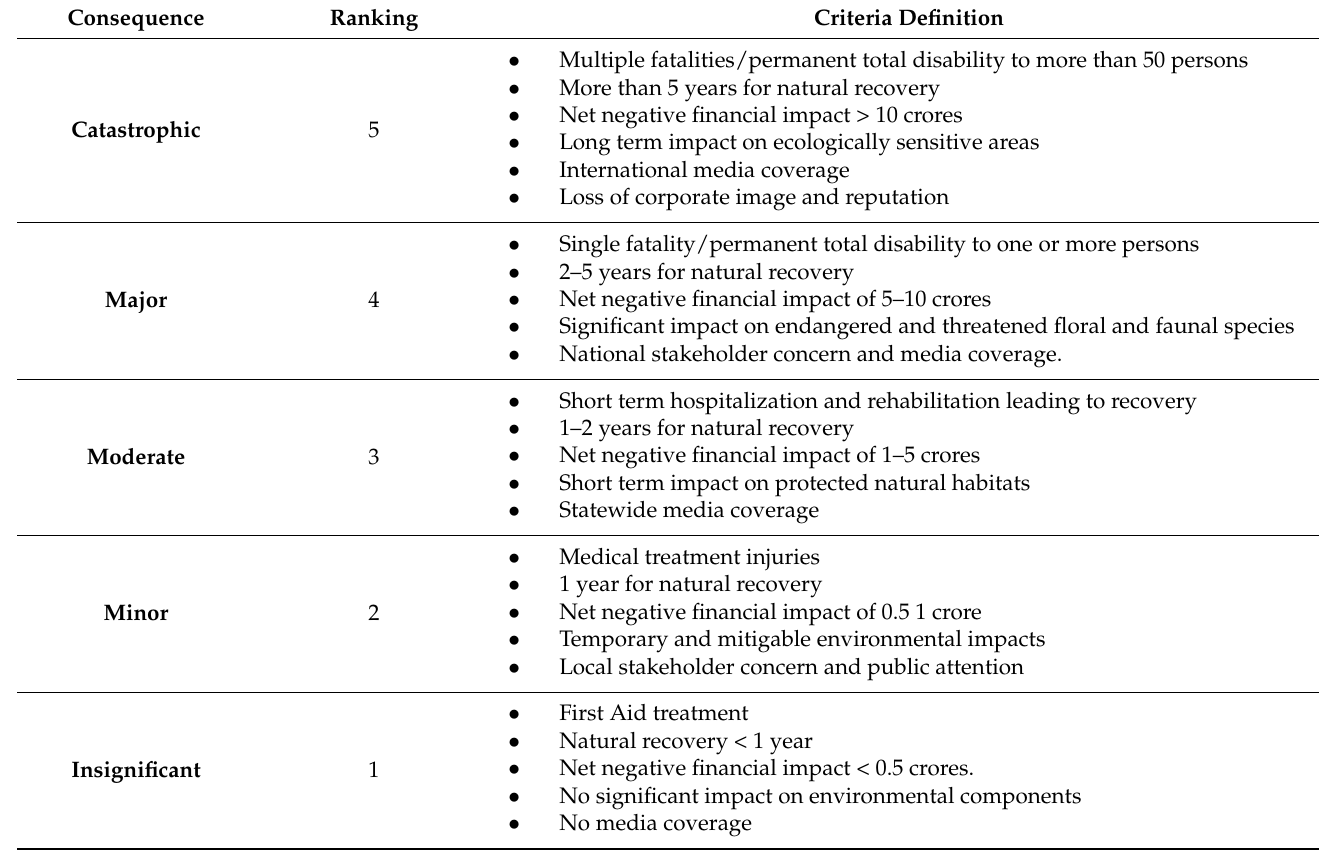
Table 2. Severity categories and criteria.